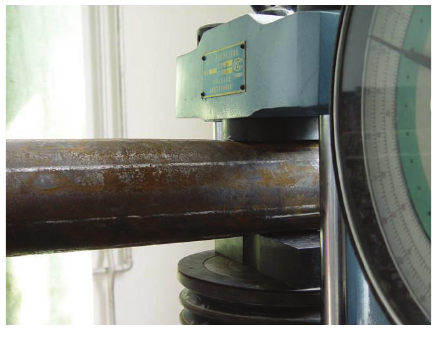
Figure 2: Stress test facility.